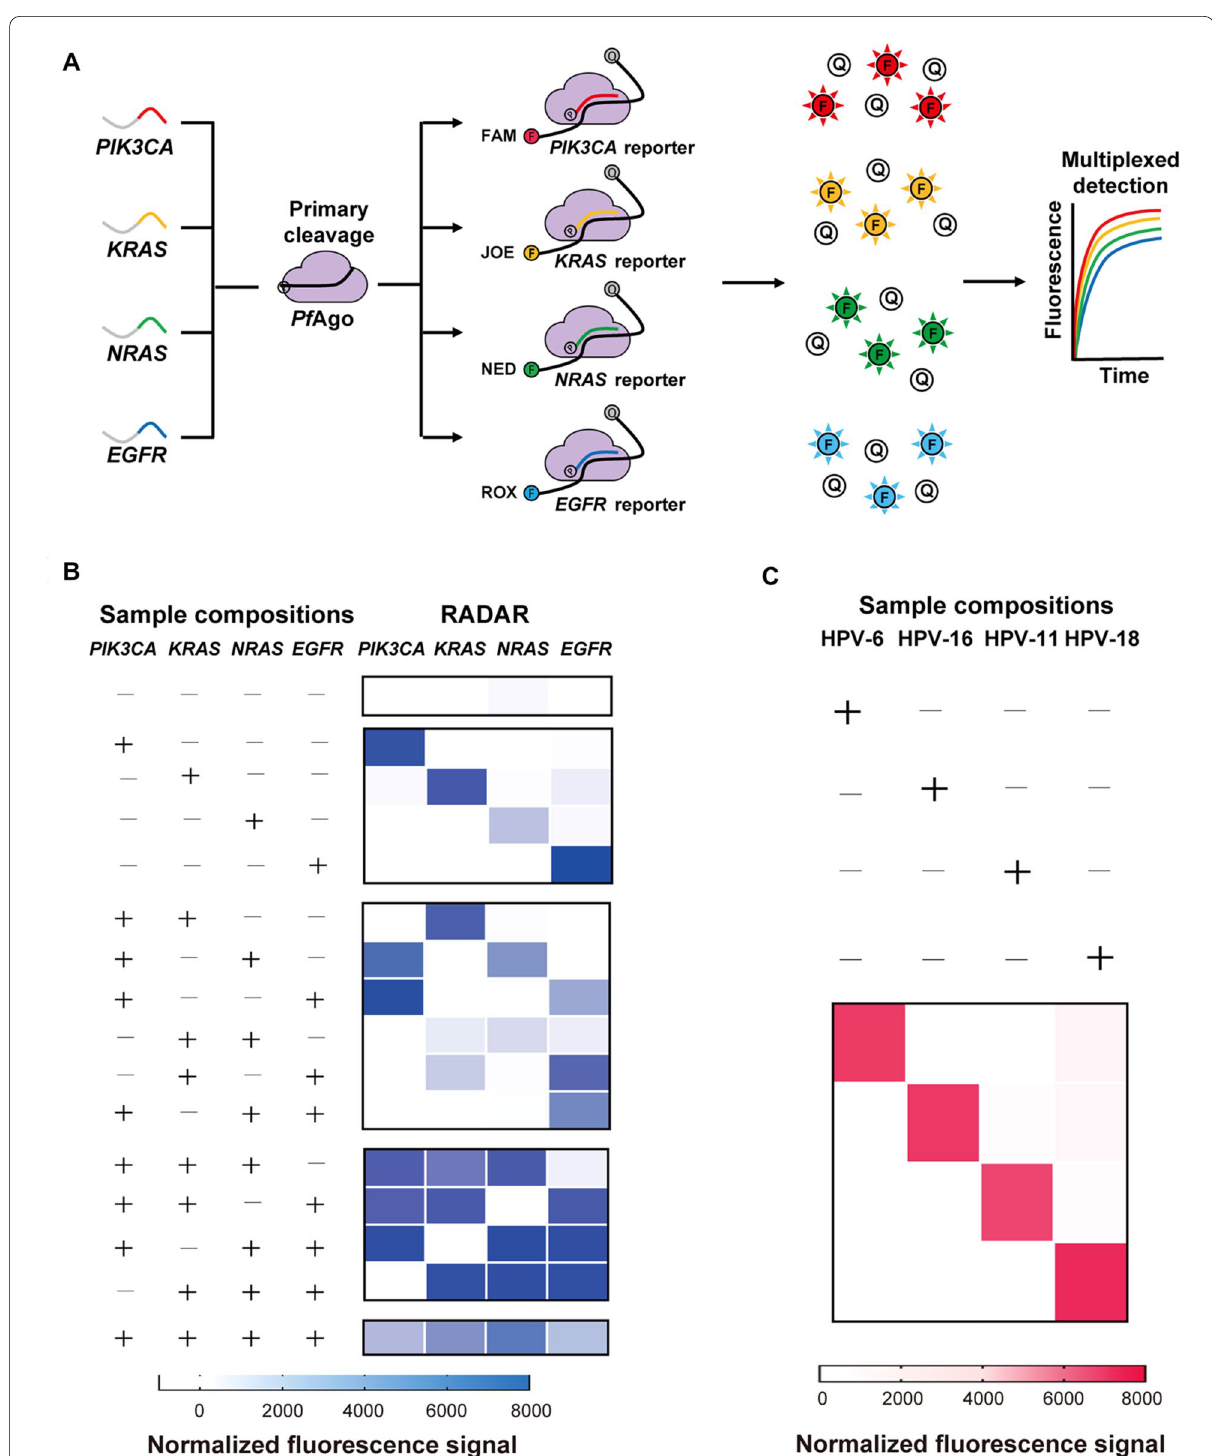
Fig. 4 RADAR for multiplex detection of nucleic acids. A Schematic of one-tube four-fluorophore multiplexing using orthogonal single-gDNA-assisted Pf Ago-mediated cleavage activity, with each gDNA designed for respective ssDNA targets. B In-sample multiplexed detection of four ssDNA targets with corresponding gDNAs designed in an orthogonal manner. C Multiplexed detection of four HPV dsDNA targets with corresponding gDNAs designed in an orthogonal